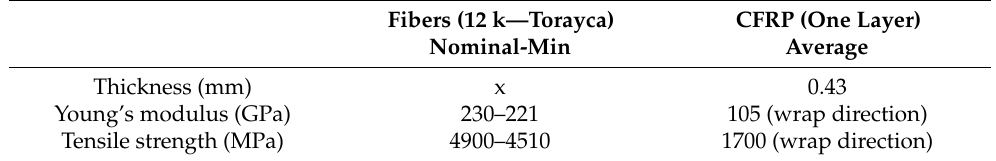
Table 3. Carbon fibers and CFRP properties.